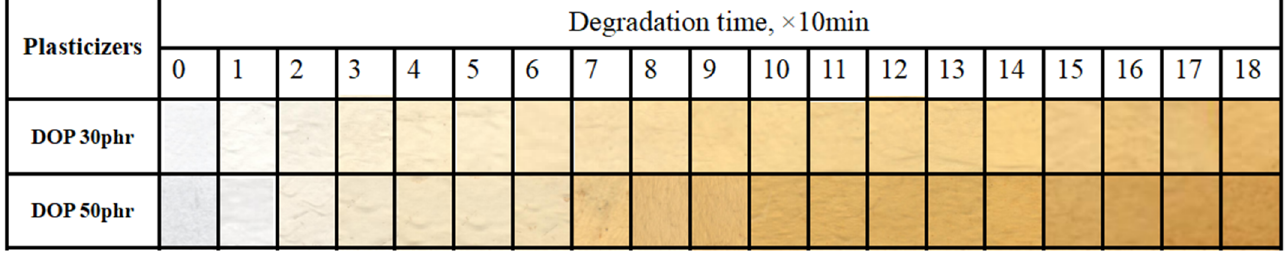
Figure 2. The transmittance ( A ) and haze ( B ) of PVC with different content of DOP. For obtaining better thermal stability and transparency of PVC sample with Zn(Arg) 2 , citric acid ester was chosen as another kind of plasticizer, which is environmentally friendly with no biological toxicity, excellent compatibility, and high plasticizing effi- ciency, especially its excellent light resistance and cold resistance. Citric acid ester is al- ways used in PVC products like children’s soft toys, medical products, cosmetics manu- facturing, and other industries [39,40]. On the other hand, citric acid ester has stronger polarity than DOP, which has better compatibility with Zn(Arg) 2 , so it can improve the dispersion of Zn(Arg) 2 in PVC matrix, leading to better thermal stability, transparency, and migration resistance of PVC samples. According to the different polarity, four kinds of citric acid ester were chosen to compound with Zn(Arg) 2 . They are trimethyl citrate (TMC), triethyl citrate (TEC), Acetyl triethyl citrate (ATEC), and tributyl citrate (TBC), which are listed in Scheme 1. The structural difference between TMC, TEC, and TBC is the different length of the carbon chain. While ATEC has four acetyl groups, one more than the others. The PVC samples with 2phr Zn(Arg) 2 and 30 phr citric acid ester were pre- pared, and its thermal stability, transparency, tensile properties, and migration ratio were also studied. DOP was as the contrast.